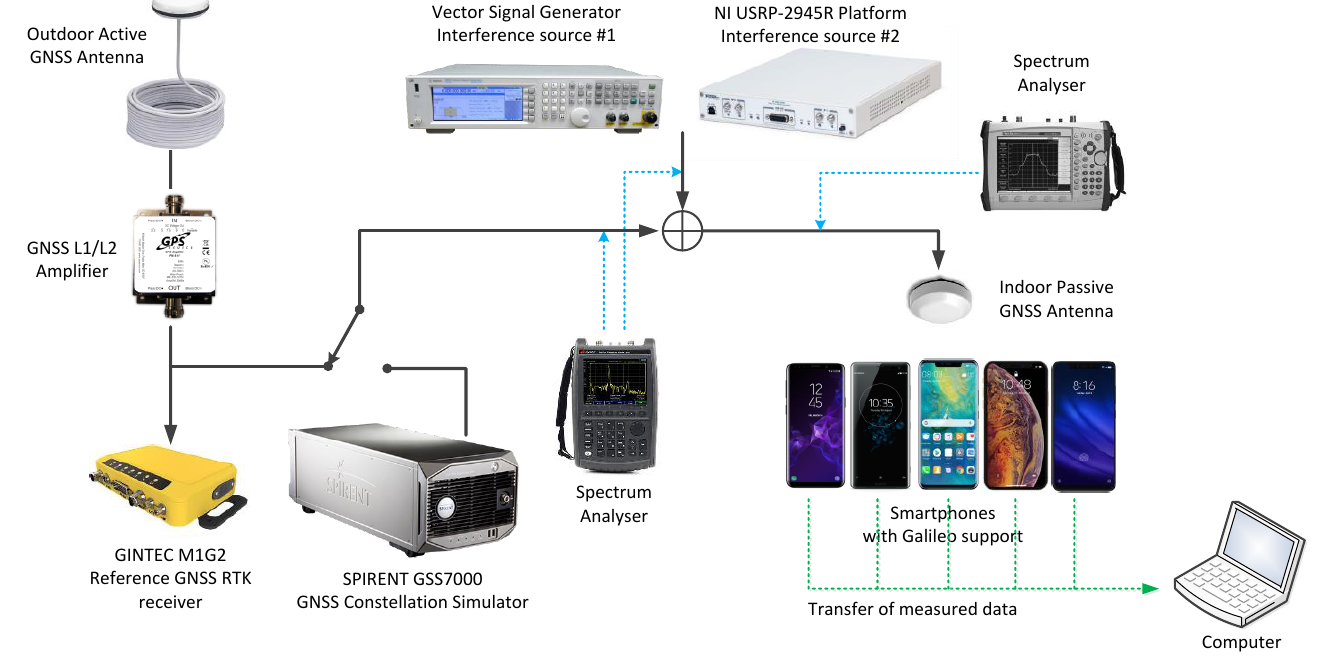
Figure 5. Jamming test measurement station.